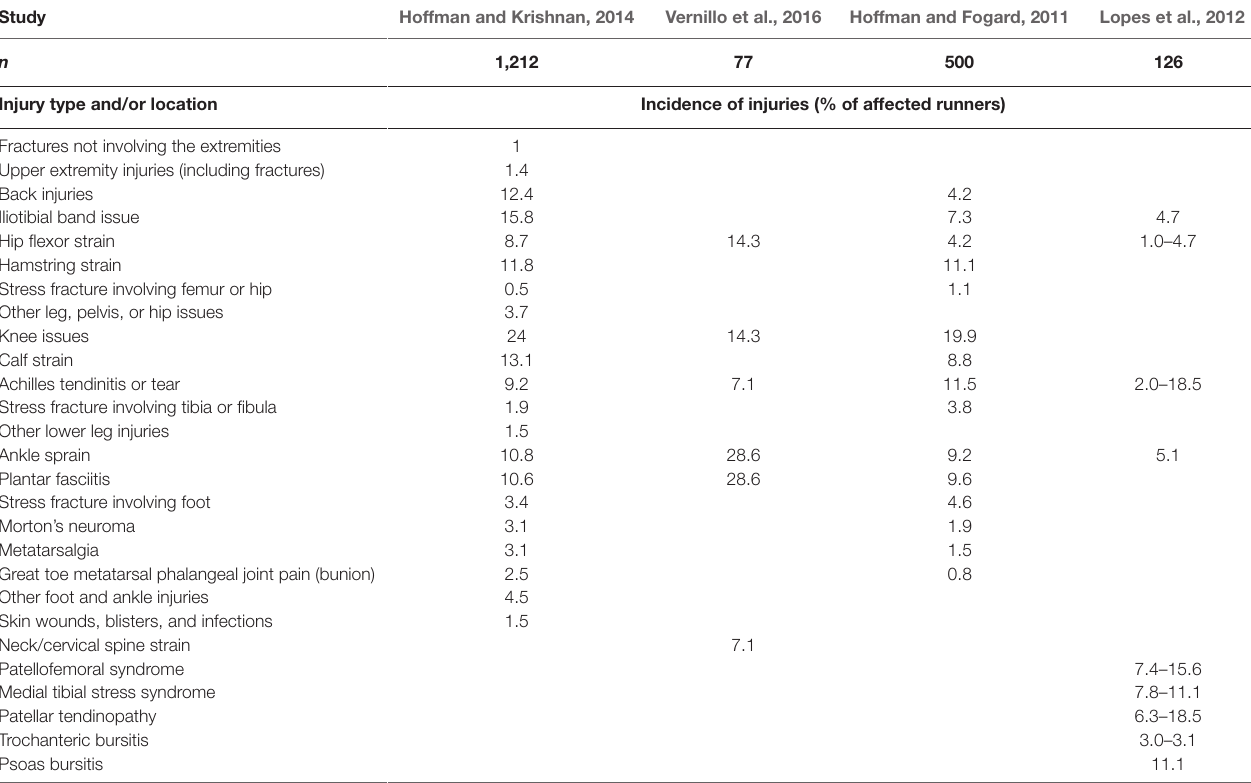
TABLE 5 | Incidence of exercise-related injuries among